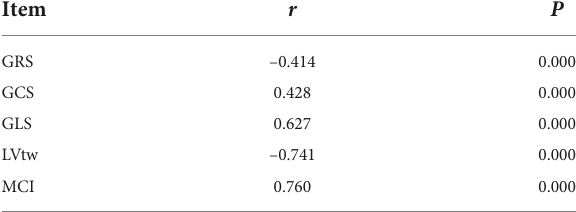
TABLE 3 Analysis on the correlations of the cumulative dose of adriamycin with GRS, GCS, GLS, LVtw, and